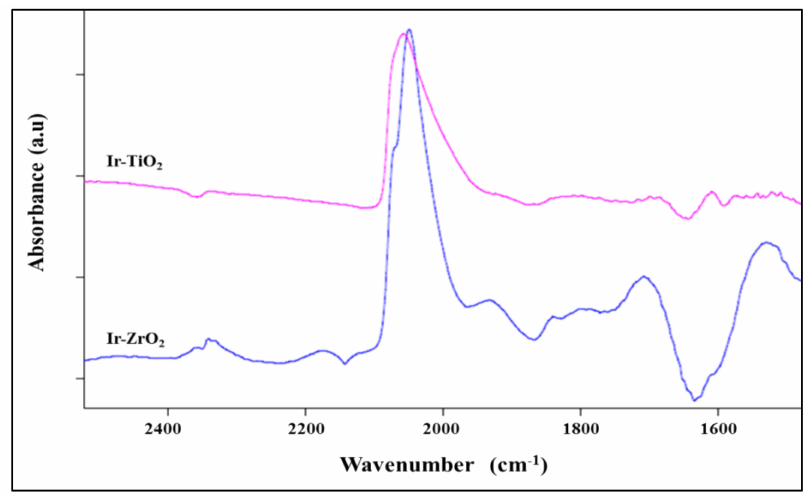
Figure 6. Fourier Transform Infrared-CO spectra of the Ir-TiO 2 and Ir-ZrO 2 catalysts (at 200 ◦